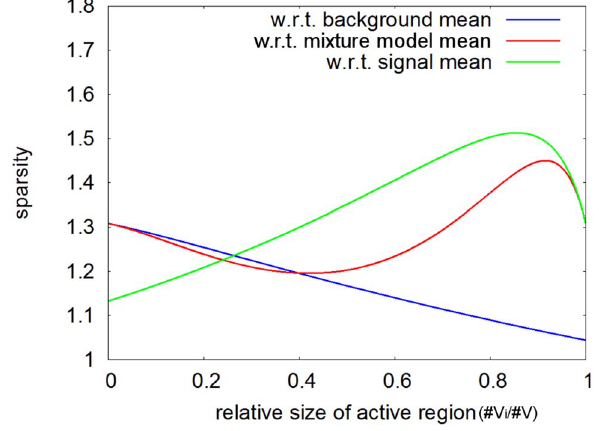
Figure 3. Sparsity measures for three different coordinate system origins ( z 0 ). Sparsity as measured with respect to different coordinate system origins ( z 0 ), as a function of the relative size of the active region. Remark that for a relative size of zero, only background samples are present and, thus, the mean of the mixture model coincides with the mean of the background (and the two sparsity measures correspond at this point). An analogous observation can be made for a relative size of one, now with respect to the activity (signal samples).